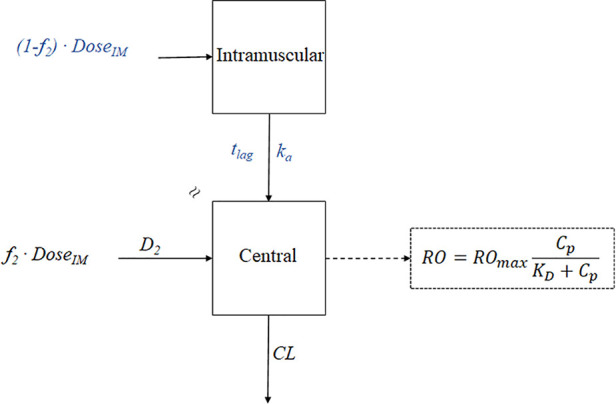
The PK-PD model of paliperidone palmitate. The absorption model was divided into two components: f
2 and (1- f2). f2 denotes the fraction that enters the central compartment via a zero-order process, and (1-f2) denotes the fraction that enters the central compartment via a first-order process. t
lag is the lag time, ka is the absorption rate, D2 is the duration of f
2 for zero-process and equal to t
lag, CL represents clearance, RO represents receptor occupancy, ROmax represents the maximal occupancy can be achieved, C
p represents the plasma concentration, and K
D is the equilibrium dissociation constant.